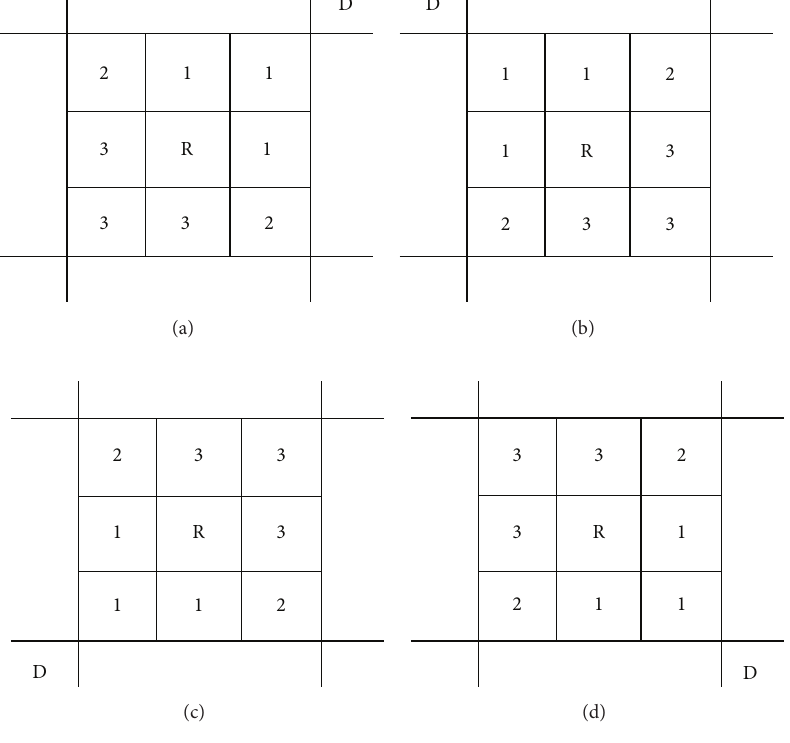
Figure 1: Schematic diagram of direction selection